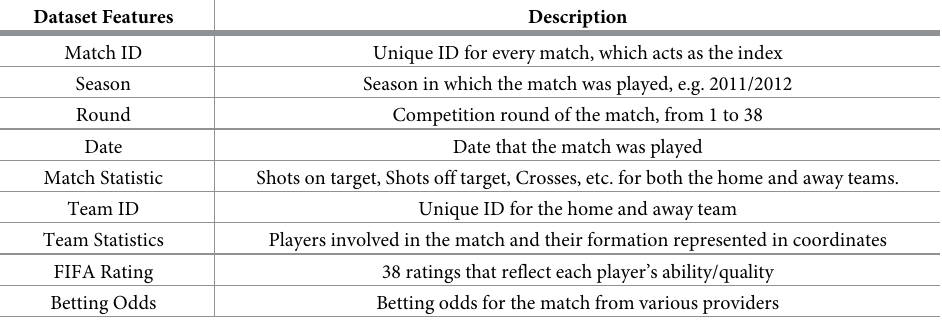
Table 1. Dataset features summary.